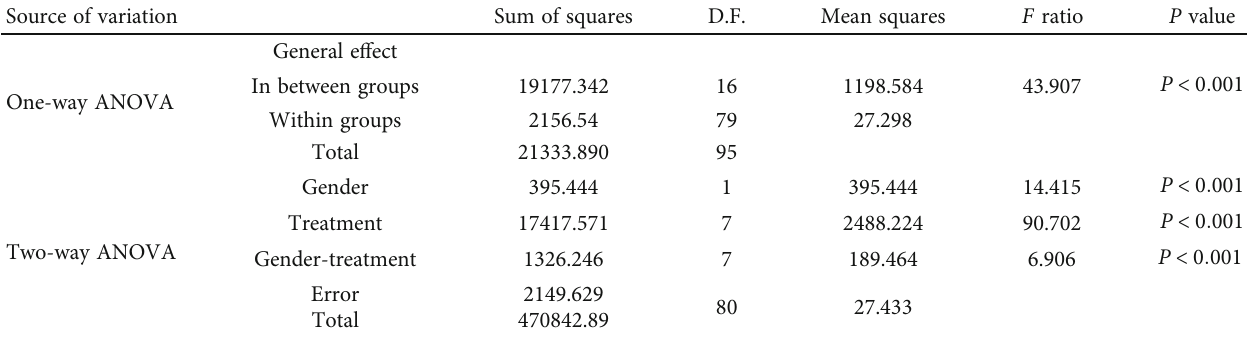
Table 4: E ff ect of MSCs and curcumin on serum TNF- α (pg/mL) level in arthritic rats. Parameter Group Group